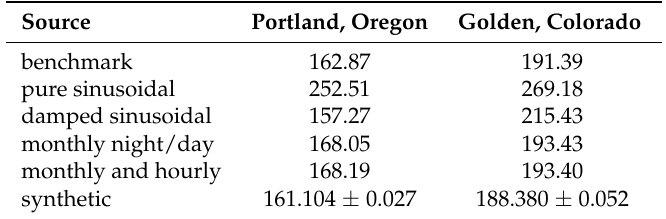
Table 3. Power of the different solar sources used in experiments (W/m 2